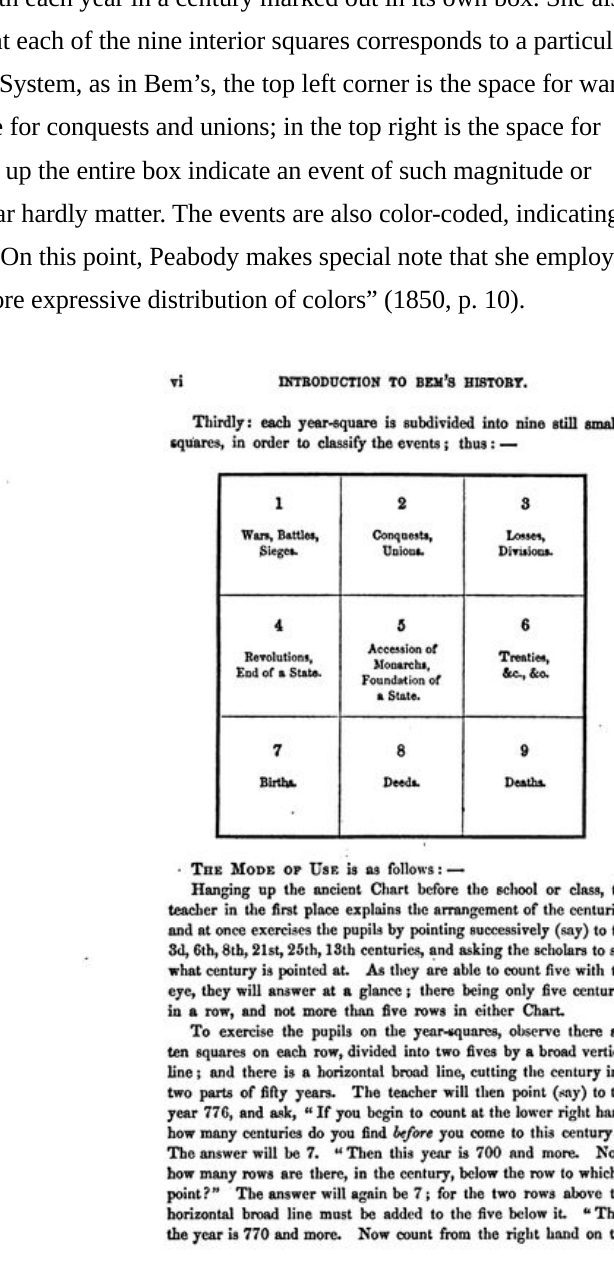
Figure 7. Two pages from a later publication of Peabody’s , Universal History; Arranged to illustrate Bem’s Charts of Chronology (1859), which show, at left, how each year in a century is positioned on a grid; and at right, how each event is positioned within each year. Image courtesy of Columbia University/Google Books. Digitized by